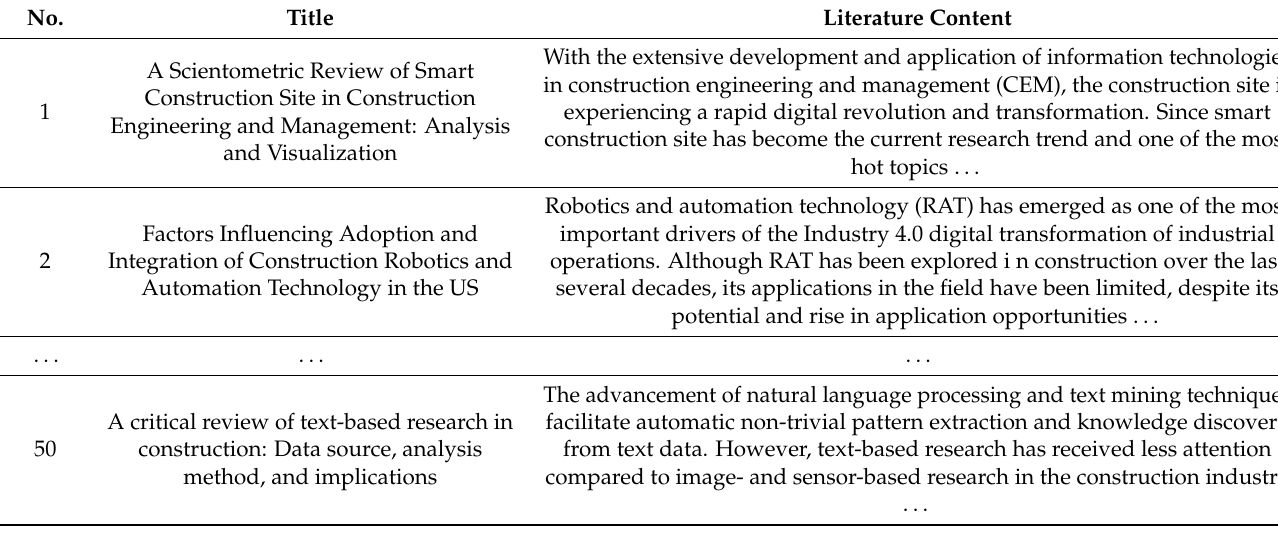
Table 1. The representative literature